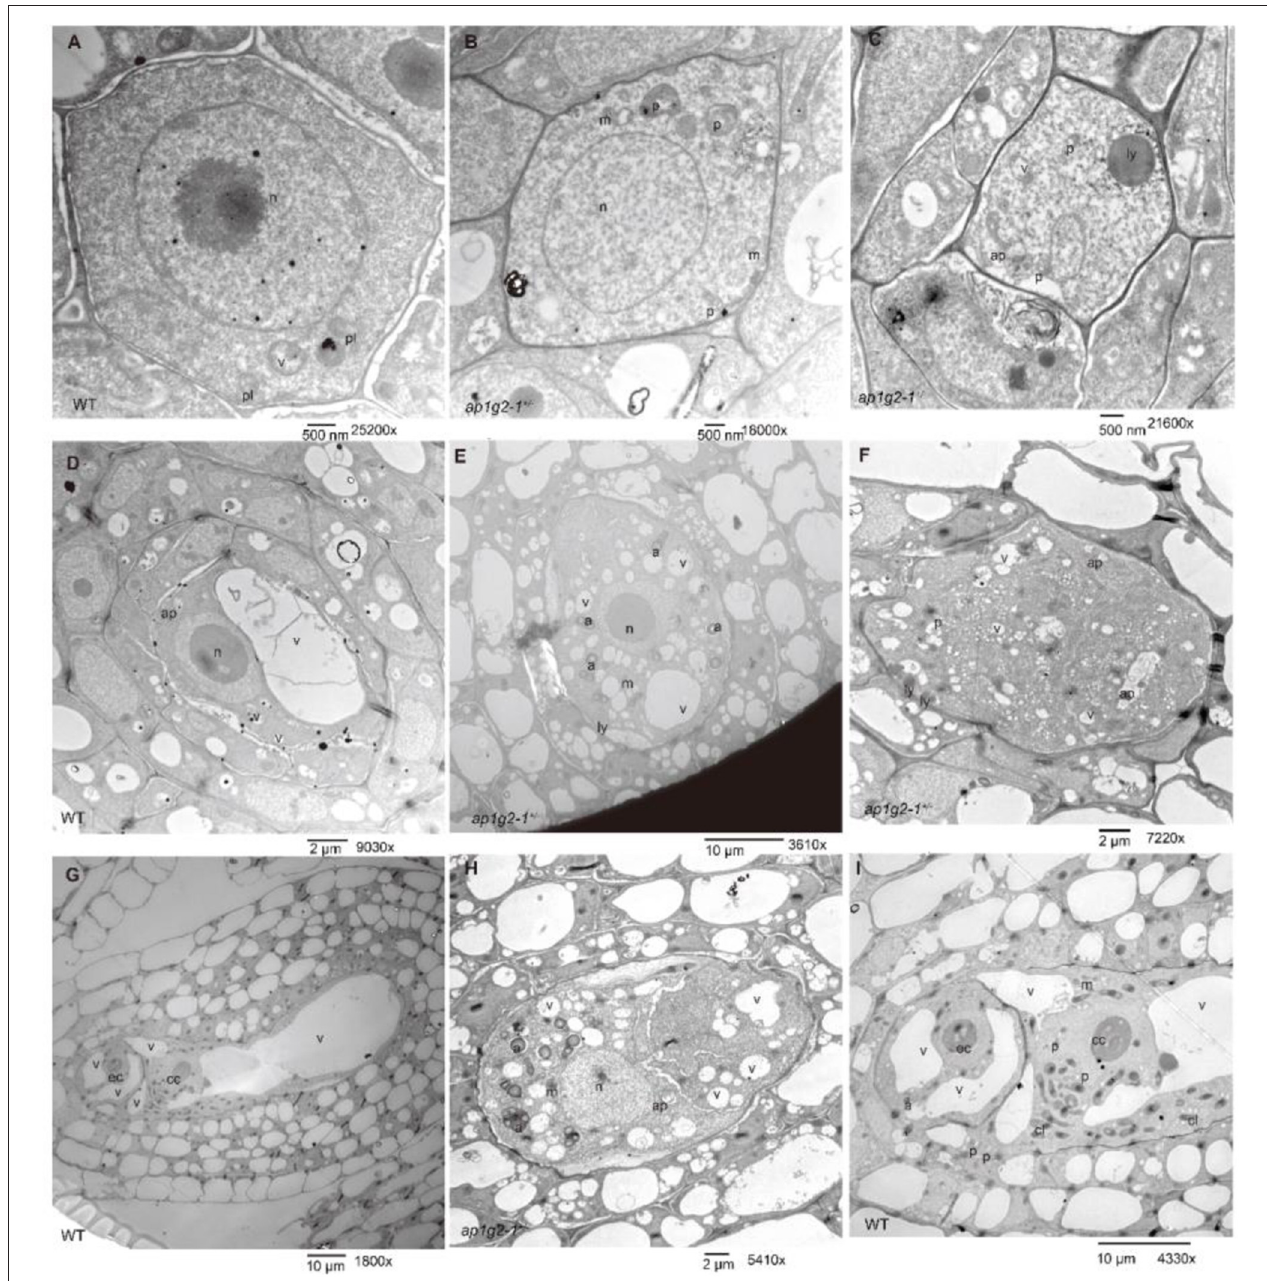
FIGURE 10 | TEM micrographs of the pyroantimonate-labeled ovules from the wild type and ap1g2-1 + / − . (A,D,G) Showed the ovules of the wild type at MMC, FG3, and FG7, respectively. (B,C) showed the ovules at the MMC stage from ap1g2-1 + / − . (E,F,H) showed the aborted ovules from ap1g2-1 + / − , while (I) was a magnification of (G) . n, nucleus; p, proplastids; v,vacuoles; m, mitochondria; ap, autophagosomes; a, amyloplasts; ly, lysosomes; cl, chloroplasts; ec, egg cell; cc, central cell. The black dots were calcium precipitates.